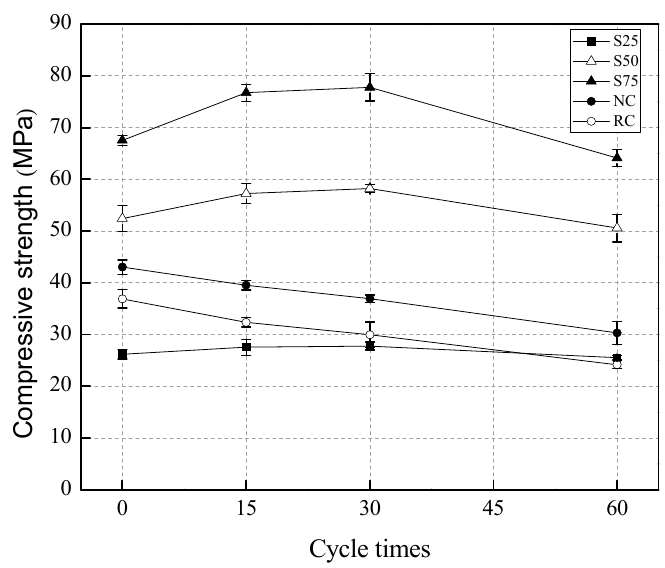
Figure 4. The influence of sulfate attack cycles on the compressive strength of specimens.